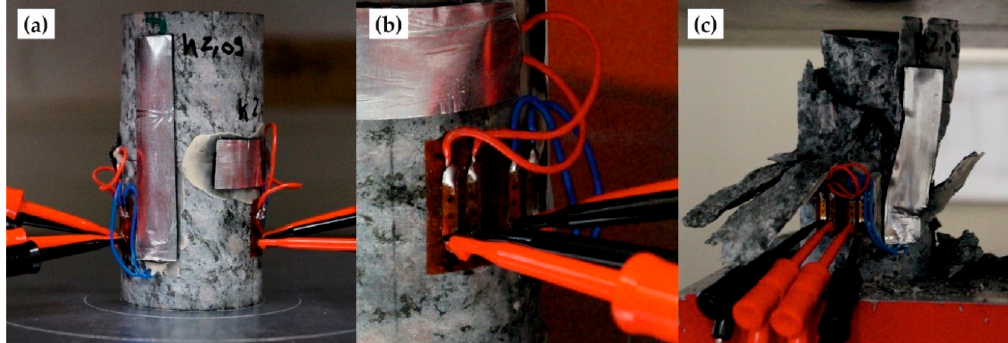
Figure A2. Testing the static modulus of elasticity on a stone under compression. ( a ) Specimen in test facility (Instron 5587), ( b ) detail showing the strain gauges and ( c ) stone after failure (after [31]).